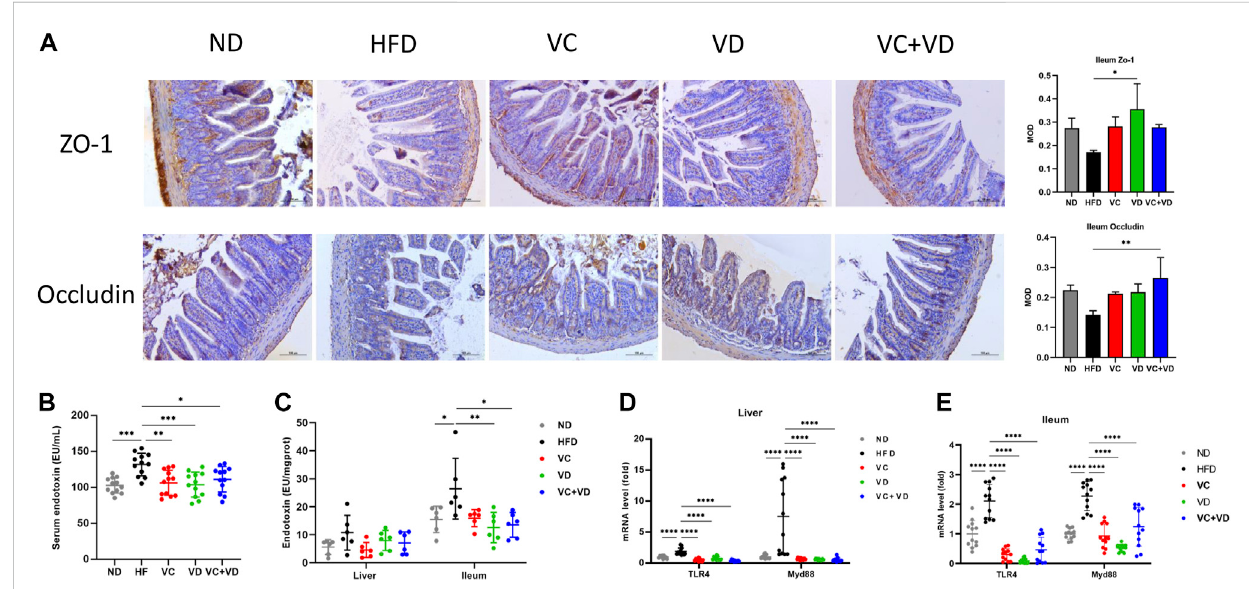
FIGURE 4 VCandVD 3 improvedgutbarrierintegrityandendotoxemiainobesemice. (A) Immunohistochemistry analysisofZO-1andOccludinintheileumof mice. The brown dot indicates the target protein. Representative images were captured. Scale bar, 100 µm. (B) Serum levels of endotoxin. (C) Endotoxin levels in theliver and ileum. (D) Endotoxin-associatedgene expressionin theliver. (E) Endotoxin-associatedgene expression inthe ileum. The gene level intheNDgroupwassetas1,andtherelativefoldincreasesweredeterminedbycomparisonwiththeNDgroup.Dataareshownasthemeans±SDs ( n = 12 mice/group), * p < 0.05, ** p < 0.01, *** p < 0.001, **** p <